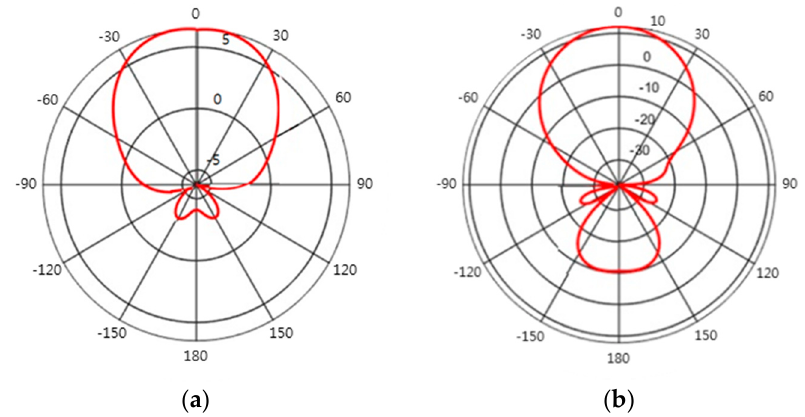
Figure 3. Directive gain g A ( φ ) of different types of directional antennas according to the orientation angle φ : ( a ) antenna gain = 6 dB; and ( b ) antenna gain = 12 dB.